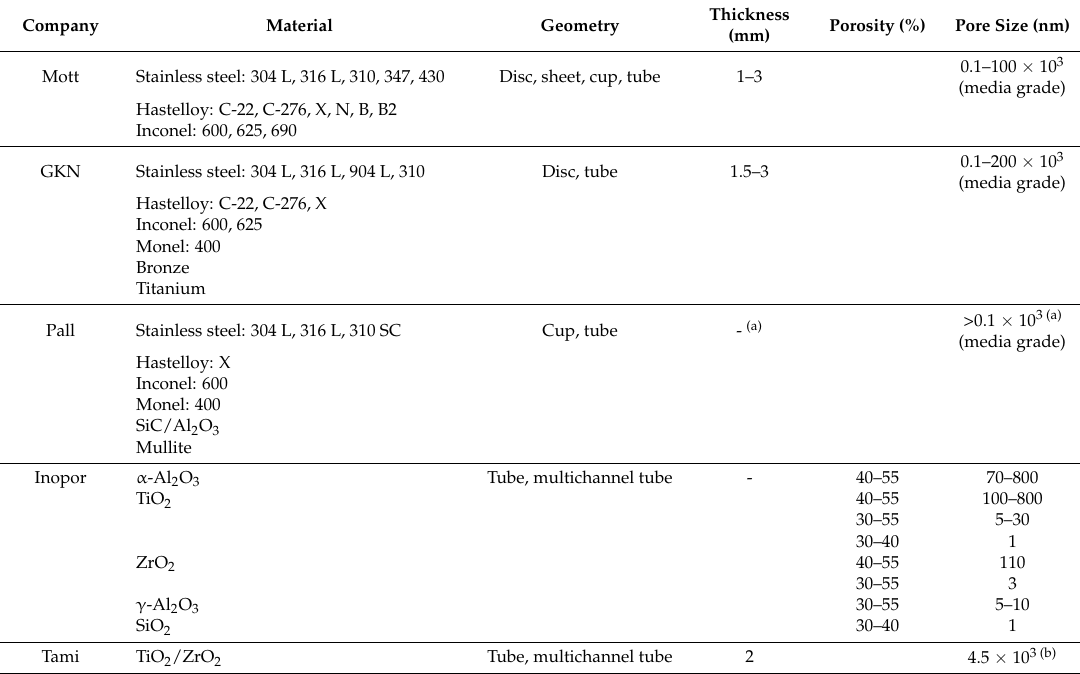
Table 1. Usual inorganic commercial supports for Pd-based membrane